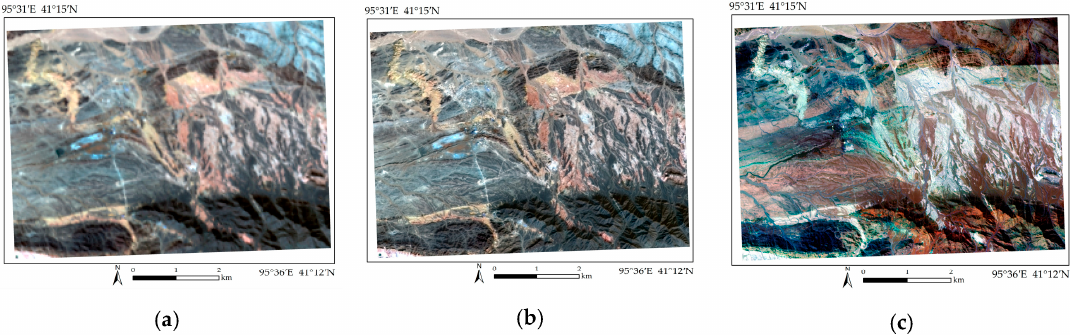
Figure 3. Preprocessed images. ( a ) GF-5 AHSI imagery (R: Band 62; G: Band 36; B: Band 20); ( b ) the fused hyperspectral imagery (R: Band 62; G: Band 36; B: Band 20); ( c ) SASI imagery (R: Band 75; G: Band 30; B: Band